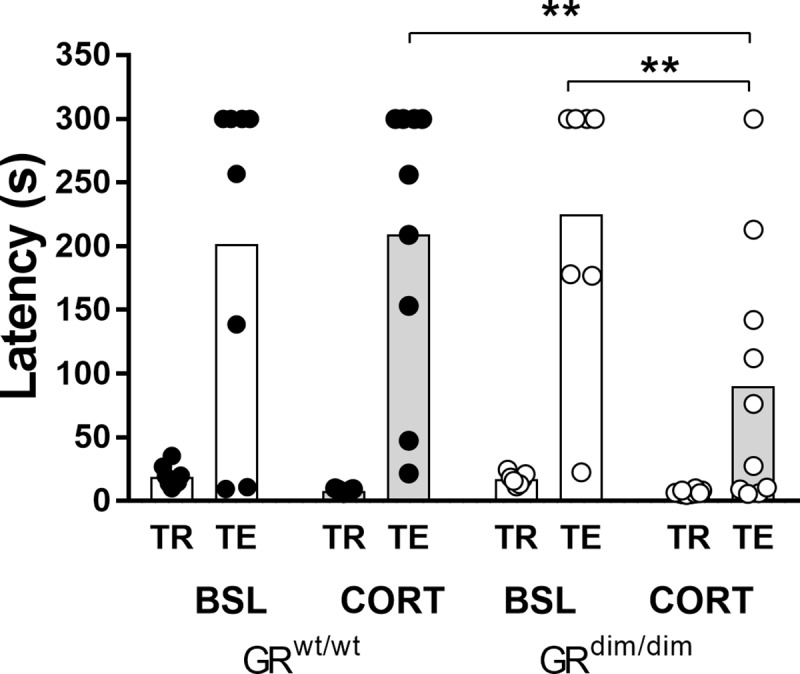
Passive avoidance.During training (TR), the animal received a mild foot shock upon entering the dark compartment. 24h later during testing (TE), entry to the dark compartment is avoided when contextual memory is intact. No differences were observed at baseline conditions (BSL). After CORT treatment, the latency in GRdim/dim mice was significantly lower when compared to BSL, as well as to GRwt/wt mice. Data are presented as mean +/- SEM. ** p < 0.01 (2-way ANOVA, post hoc with Sidak correction). Baseline: n = 12 GRwt/wt and n = 11 GRdim/dim mice; CORT: n = 9 GRwt/wt and n = 10 GRdim/dim mice.